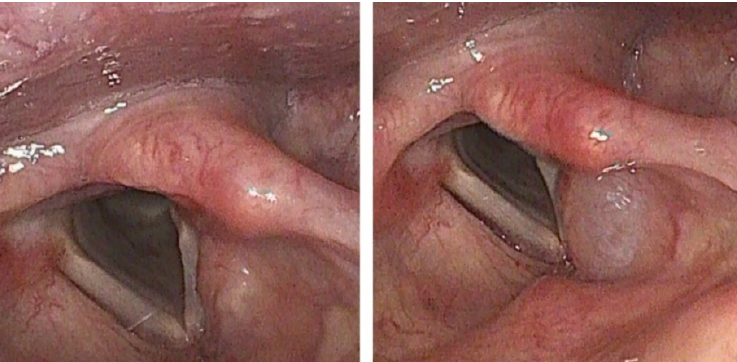
Figure 2. Endoscopic image of larynx before ( left ) and immediately after ( right ) supraglottic BTX injection showing visible submucosal bleb at injection site.